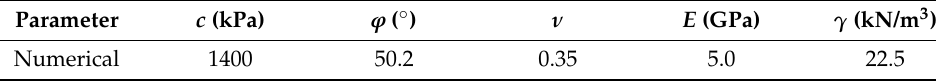
Table 3. Physical and mechanical parameters of ridge slope rock